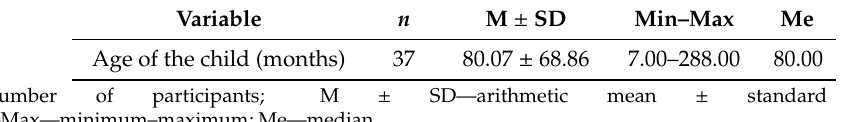
Table 3. The age of the child (months) in the group of women having children.